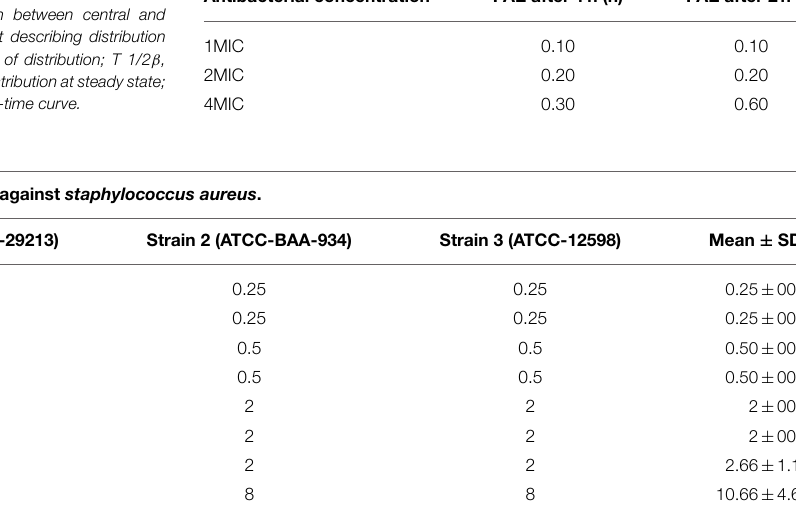
TABLE 3 | Post antibiotic effect (PAE) after 1 and 2h. (ATCC-12598). Antibacterial concentration